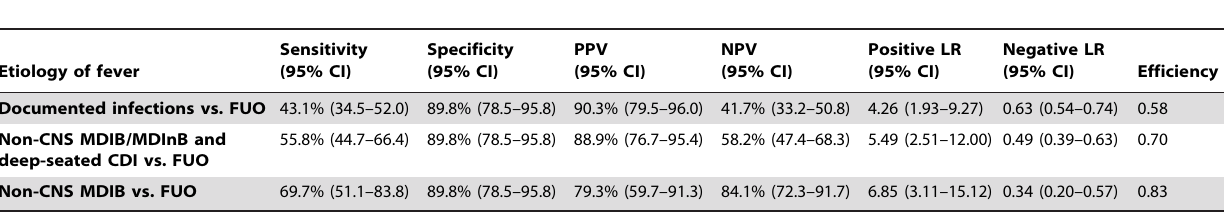
Table 3. Diagnostic performance of PCT at the 500 pg/mL cut-off on day 2 after onset of fever in i) documented infections (MDIB, MDInB and CDI) vs. FUO, ii) non-CNS MDIB, non-CNS MDInB and deep-seated CDI vs. FUO, and iii) non-CNS MDIB vs. FUO.